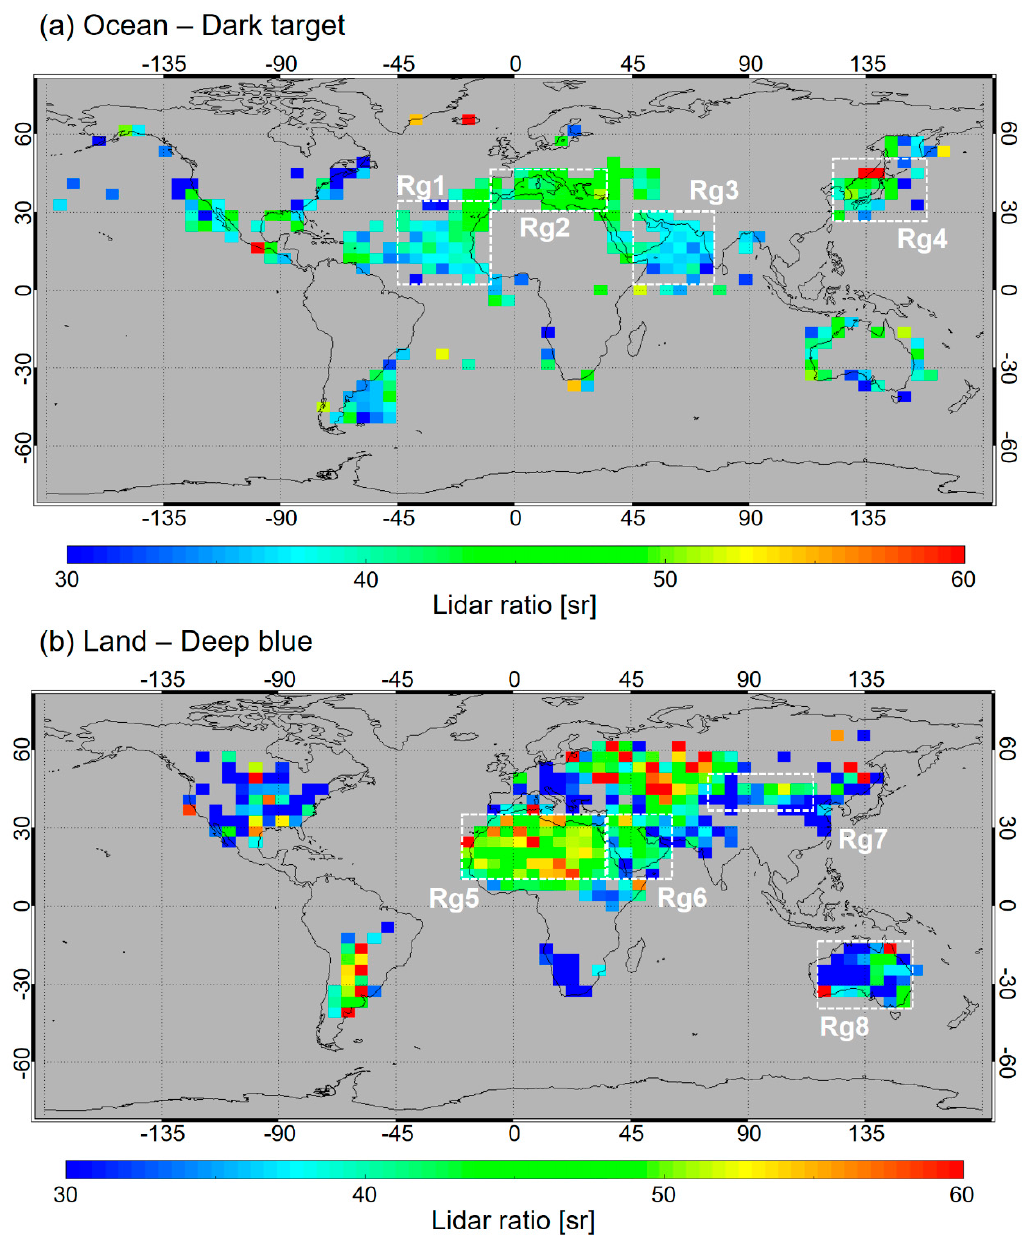
Figure 5. The global distribution of the retrieved lidar ratio ( a ) over the ocean using MODIS DT AOD as a constraint and ( b ) over land using MODIS DB AOD as a constraint from 2007 to 2011.